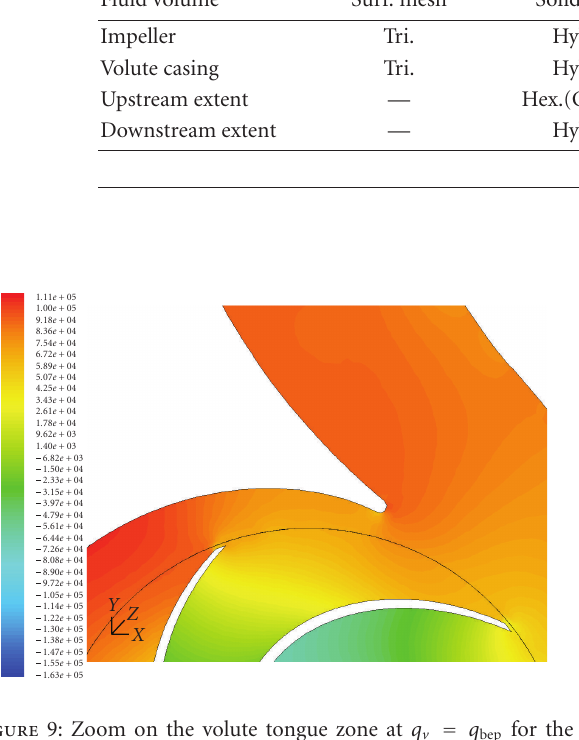
Figure 9: Zoom on the volute tongue zone at q v = q bep for the original pump—numerical static pressure